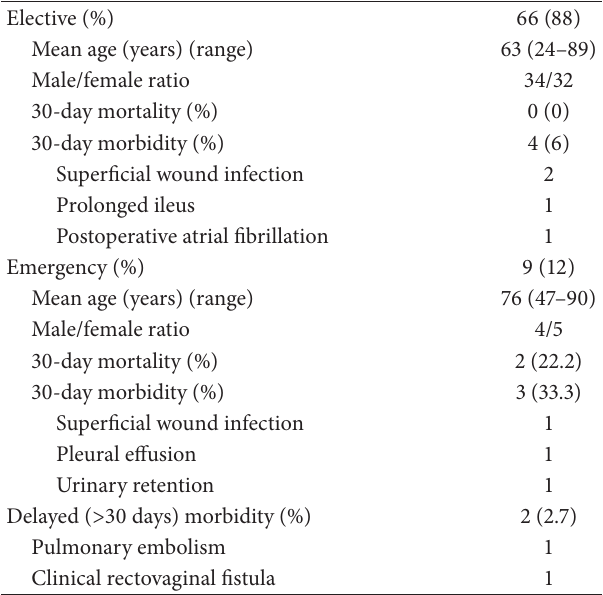
Table 4: Summary of morbidity and mortality rates following 75 laparoscopic large bowel or rectal